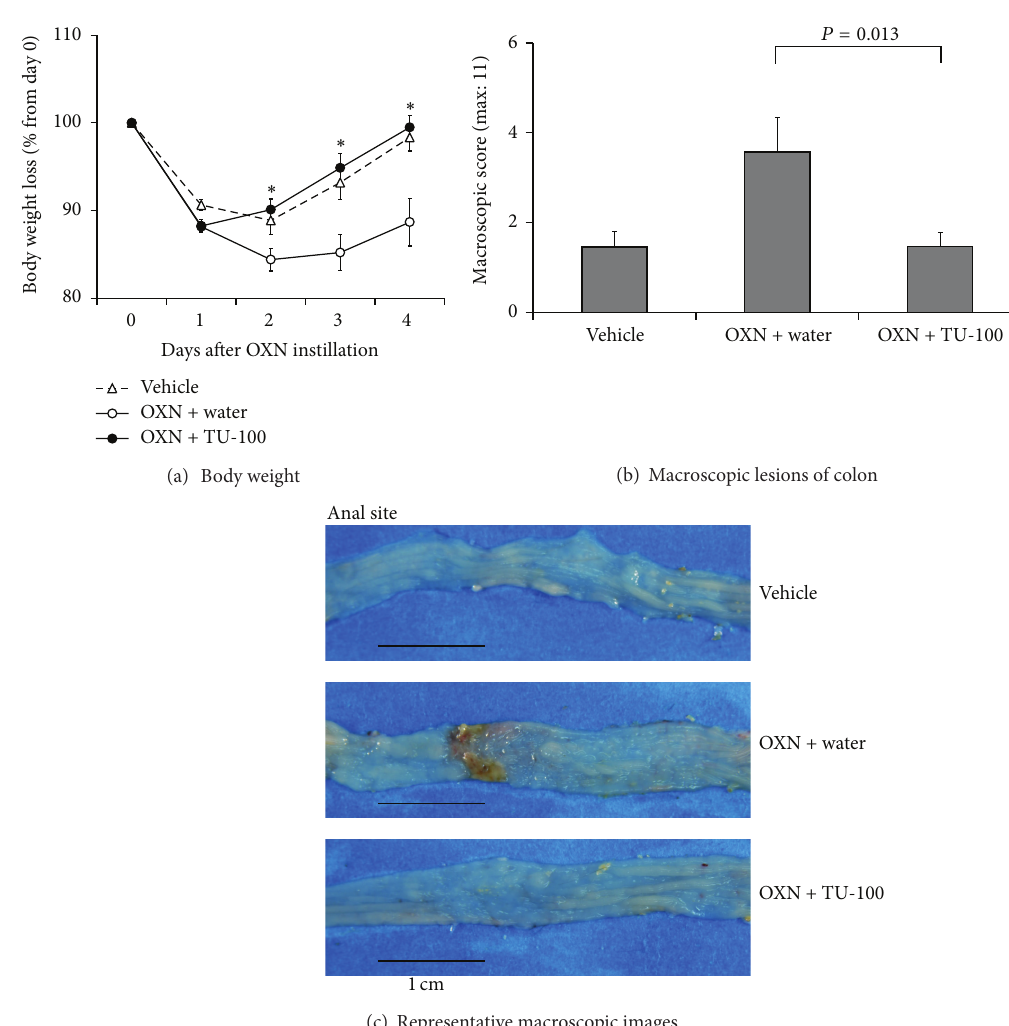
Figure 1: Effects of TU-100 on body weight and macroscopic colon lesions in OXN-induced colitis. Mice were presensitized with oxazolone (OXN, 1mg/100 𝜇 L applied to skin), and then OXN (1mg/100 𝜇 L) or vehicle, 50% ethanol, was instilled intrarectally (i.r.). TU-100 (900mg/kg) was given orally to mice several hours, 1, 2, and 3 days after OXN instillation, and mice were sacrificed 4 days after OXN instillation. Body weight changes after OXN instillation (a), and macroscopic scores of colon lesions (b) are shown. Representative macroscopic images of each group are shown (c). Vehicle: 50% ethanol i.r. + water p.o., 𝑁 = 11 , OXN + water: OXN i.r. + water p.o., 𝑁 = 14 , OXN + TU-100: OXN i.r. + TU-100 p.o., 𝑁 = 15 , ∗ 𝑃 < 0.05 versus colitis control by Student’s t-